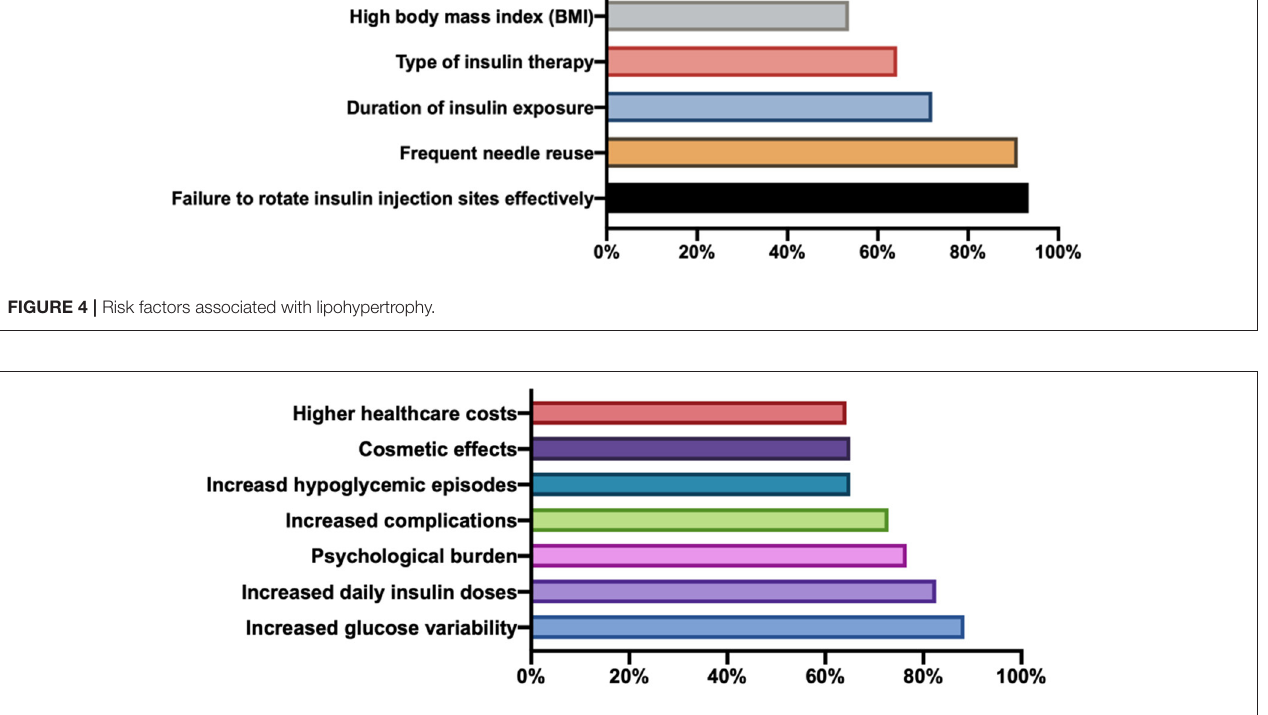
FIGURE 5 | Clinical impacts of